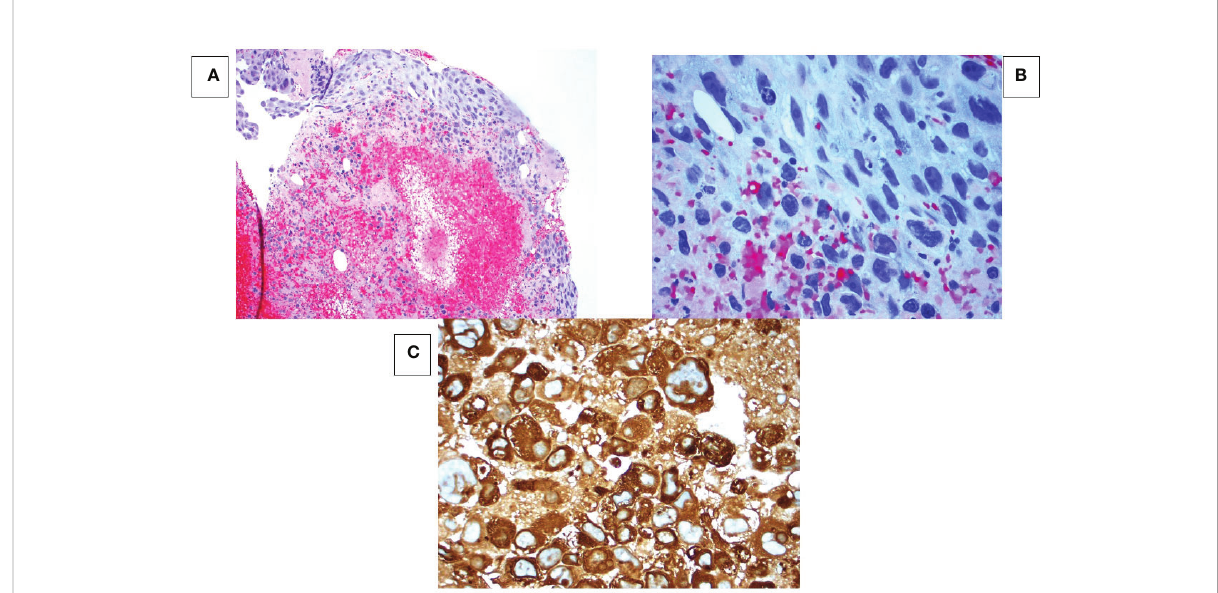
FIGURE 1 Breast mass at 10 o ’ clock position. (A) Hematoxylin-eosin (HE) stain at 100x magni fi cation shows tumor cells in a hemorrhagic necrotic background. (B) HE stain at 400x magni fi cation shows sheet-like formation of epithelial cells with pleomorphic hyperchromatic nuclei, multiple prominent nucleoli and abundant vacuolated cytoplasm. No syncytiotrophoblastic cells are seen. (C) Immunohistochemistry shows all cancer cells strongly express human chorionic gonadotropin